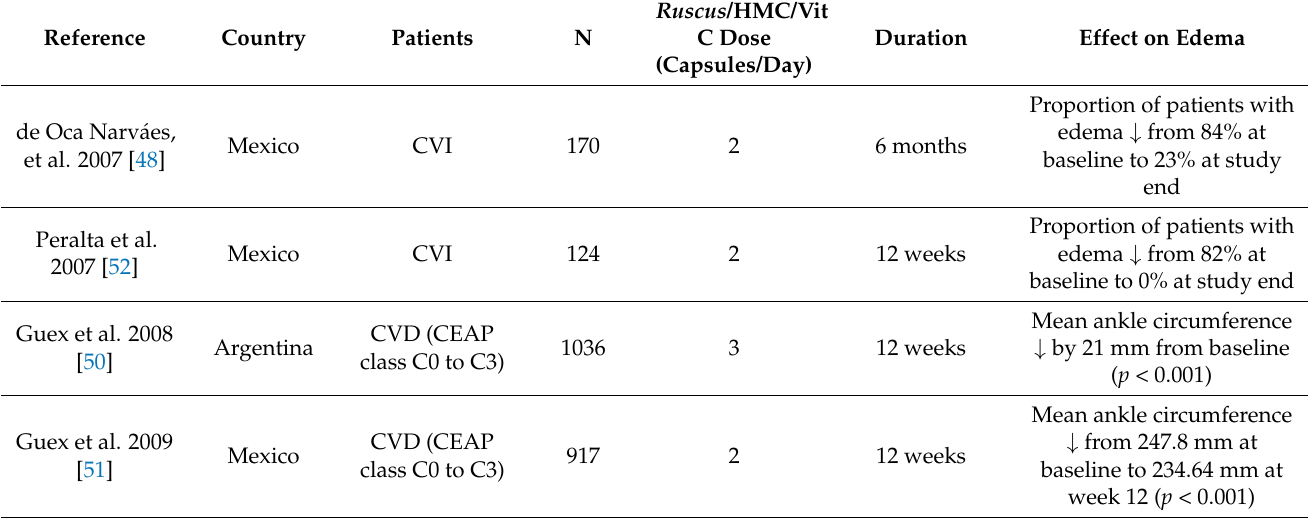
Table 2. Observational, prospective studies examining the effects Ruscus aculeatus extract,